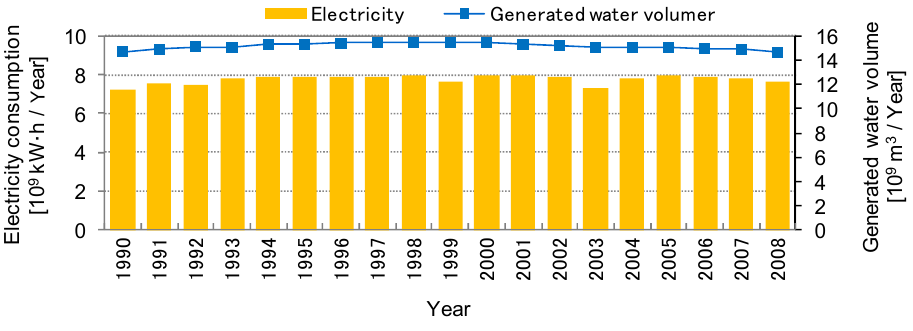
Figure 3. Generated fresh water volumes and electricity consumptions for all water works in